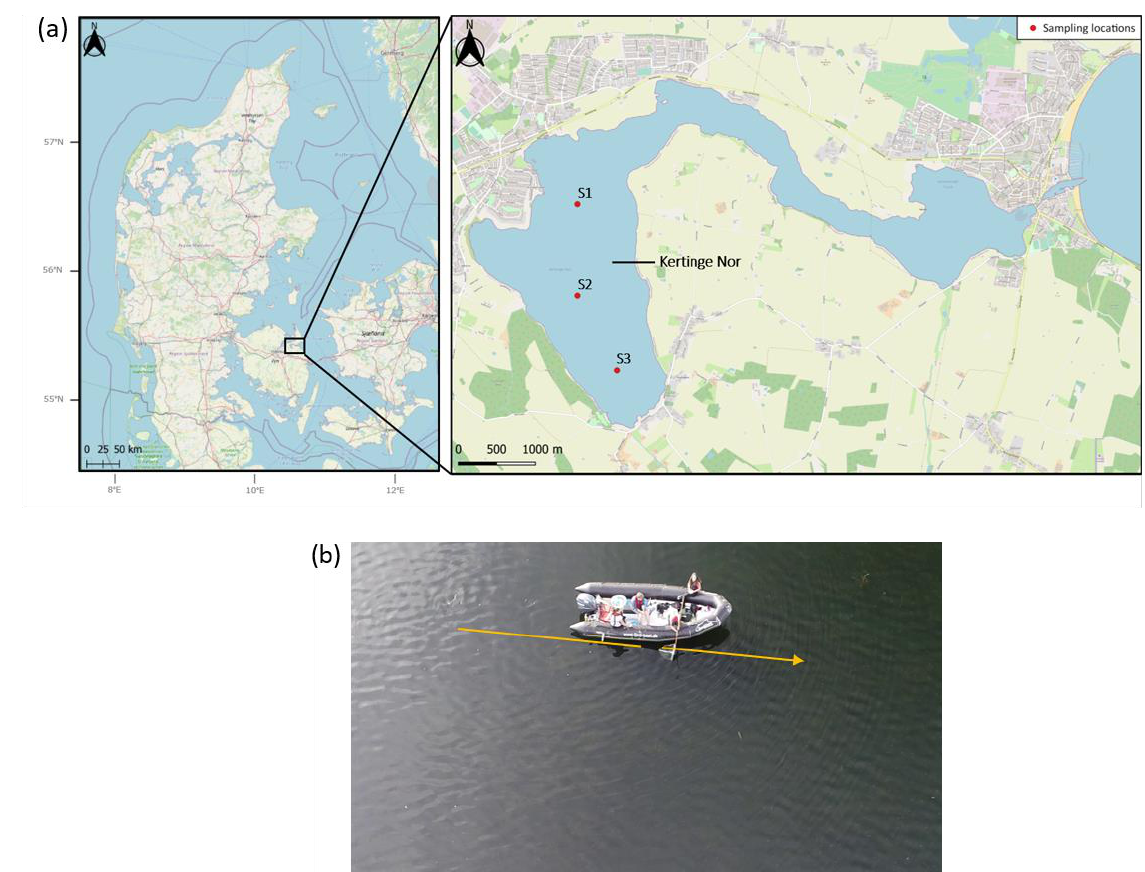
Figure 1. ( a ) Locations of sampling stations in Kertinge Nor. (S1) 55°26′56′′ N, 10°33′50′′ E; (S2) 55°26′15′′ N, 10°33′55′′ E; (S3) 55°25′58′′ N, 10°34′12′′ E. (Map projection: EPSG: 32632—WGS 84/UTM Zone 32N. © OpenStreetMap contributors [36]). The map was produced with QGIS V. 3.10.3 (QGIS Development Team [37]); core data is available under the Open Database License (https://www.openstreetmap.org/copyright accessed on 1 May 2021). ( b ) Drone view of jellyfish sampling